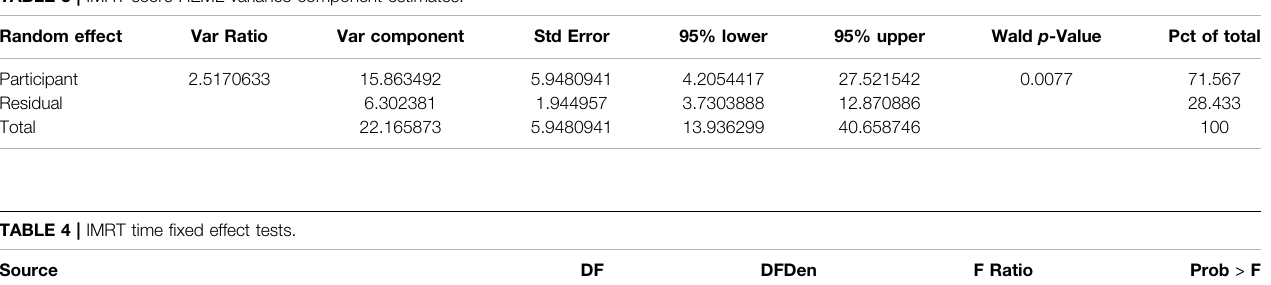
TABLE 3 | IMRT score REML variance component estimates.